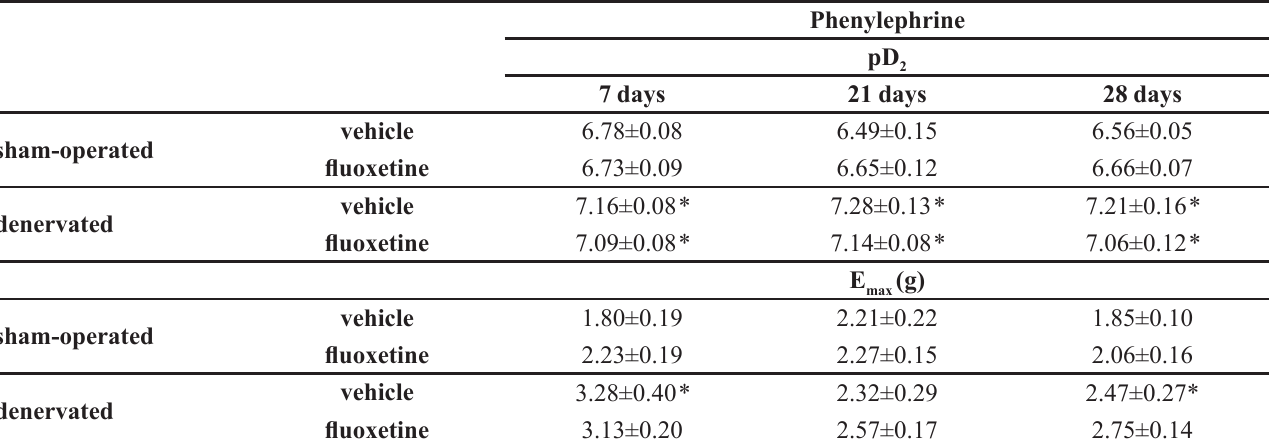
and maximum amplitude of contraction (E ) in grams of tension from the phenylephrine concentration response- TABLE I - pD 2 max curves obtained in vas deferens from sham-operated and denervated rats treated with vehicle or fluoxetine for 7, 21 and 28 days. Each value represents the mean ± standard error from 9 to 12 experiments